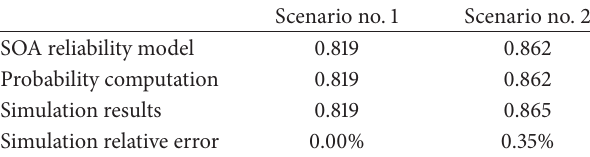
Table 4: System reliability model validation results.